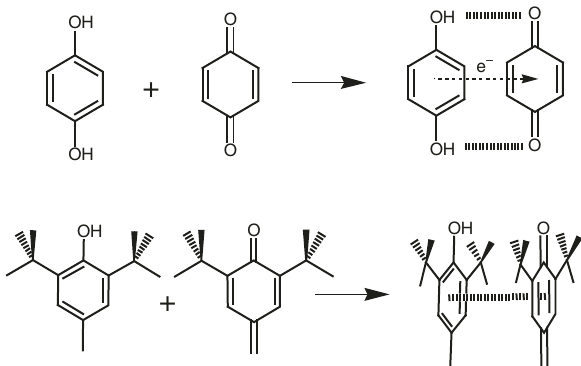
Fig. 1 Formation of quinhydrone and hemiquinhydrone. a Quinhydrone complex formed between an electron-rich hydroquinone and electron- de fi cient benzoquinone. b Proposed formation of hemiquinhydrone complex in compounds containing 3,5-di-t-butyl-4-hydroxyphenyl